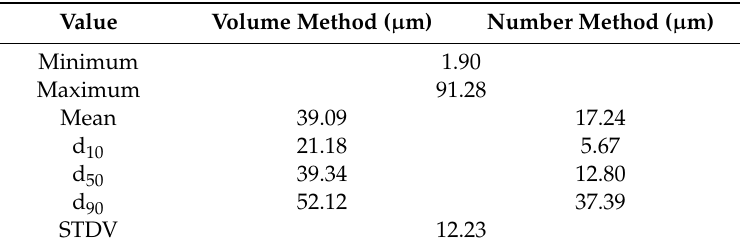
Table 2. Diameter report of 316L particles.